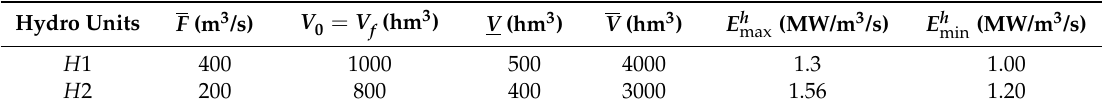
Table 2. Parameter data of hydro units.